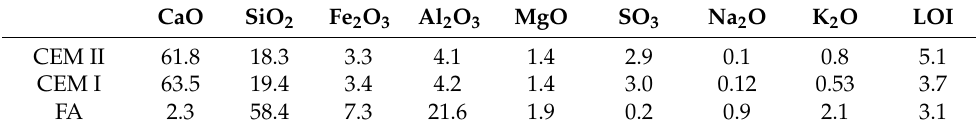
Table 1. Composition of binder materials presented as the percentages of the total